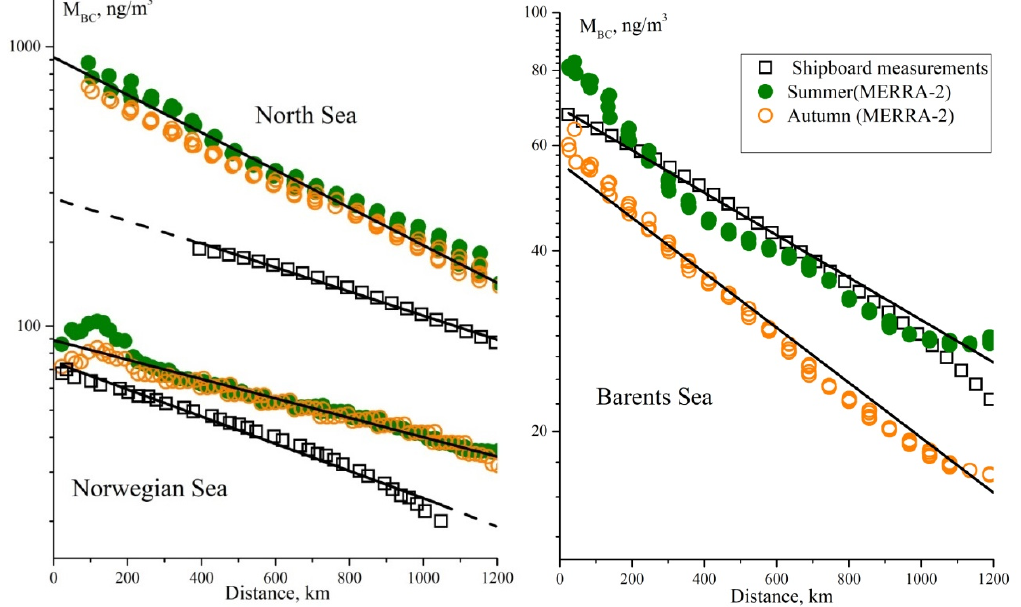
Figure 9. Changes in black carbon concentrations with distance from land over the North, Norwegian and Barents seas (lines show extrapolations using an exponential function).